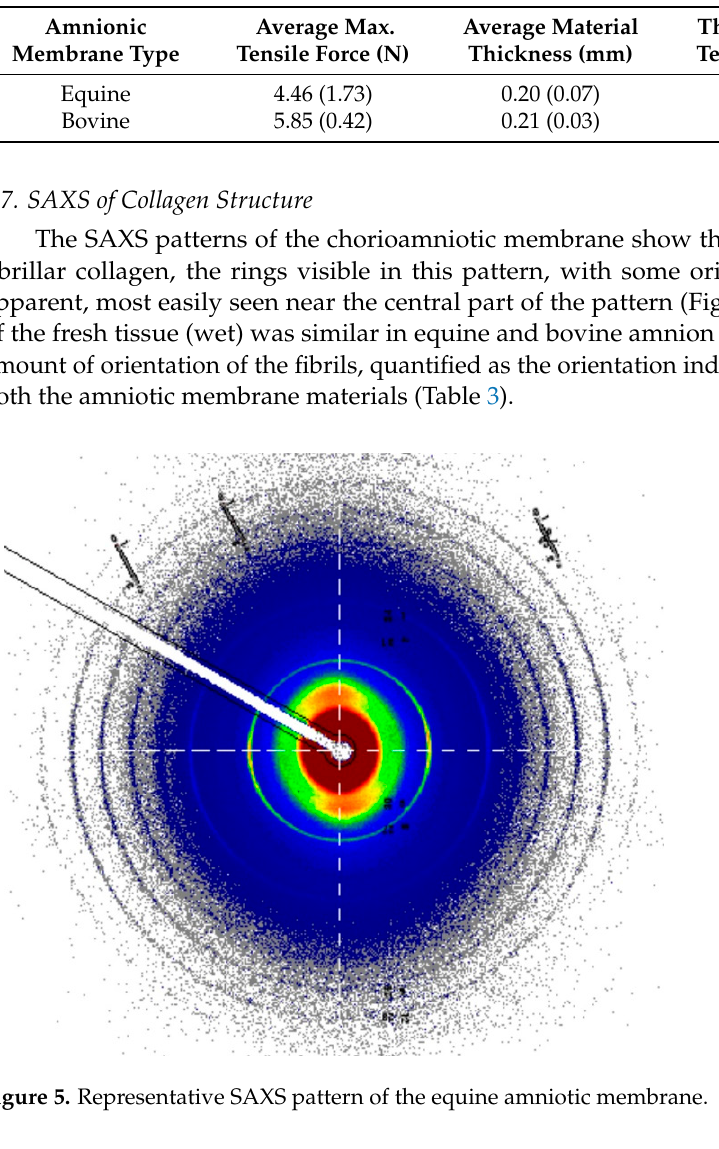
Table 2. Tensile strength of chorioamnion.